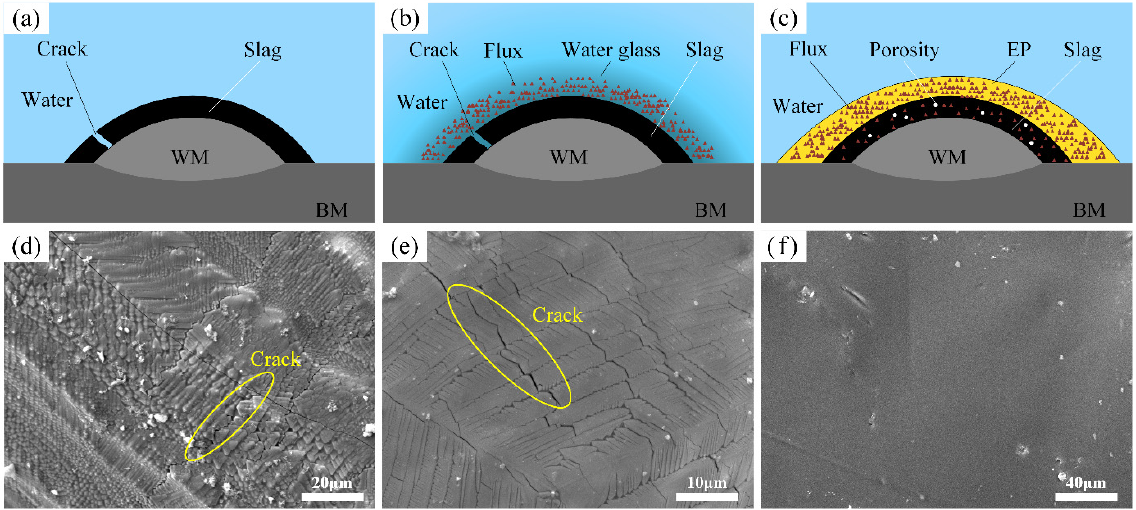
Figure 5. Slag structures of different welding processes. ( a – c ) Schematic of slag macrostructures for UWW, WG-USAW and EP-USAW; ( d – f) SEM results of UWW, WG-USAW and EP-USAW.